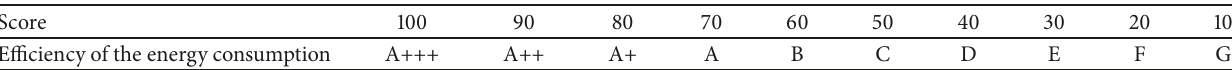
Table 4: Spectrum for efficiency of the energy